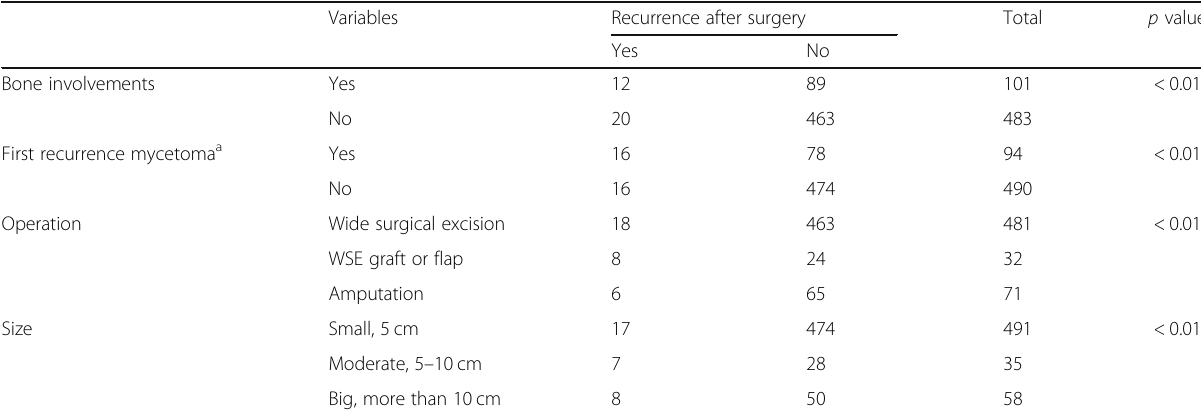
Table 4 Factors associated with recurrent mycetoma ( N = 584)